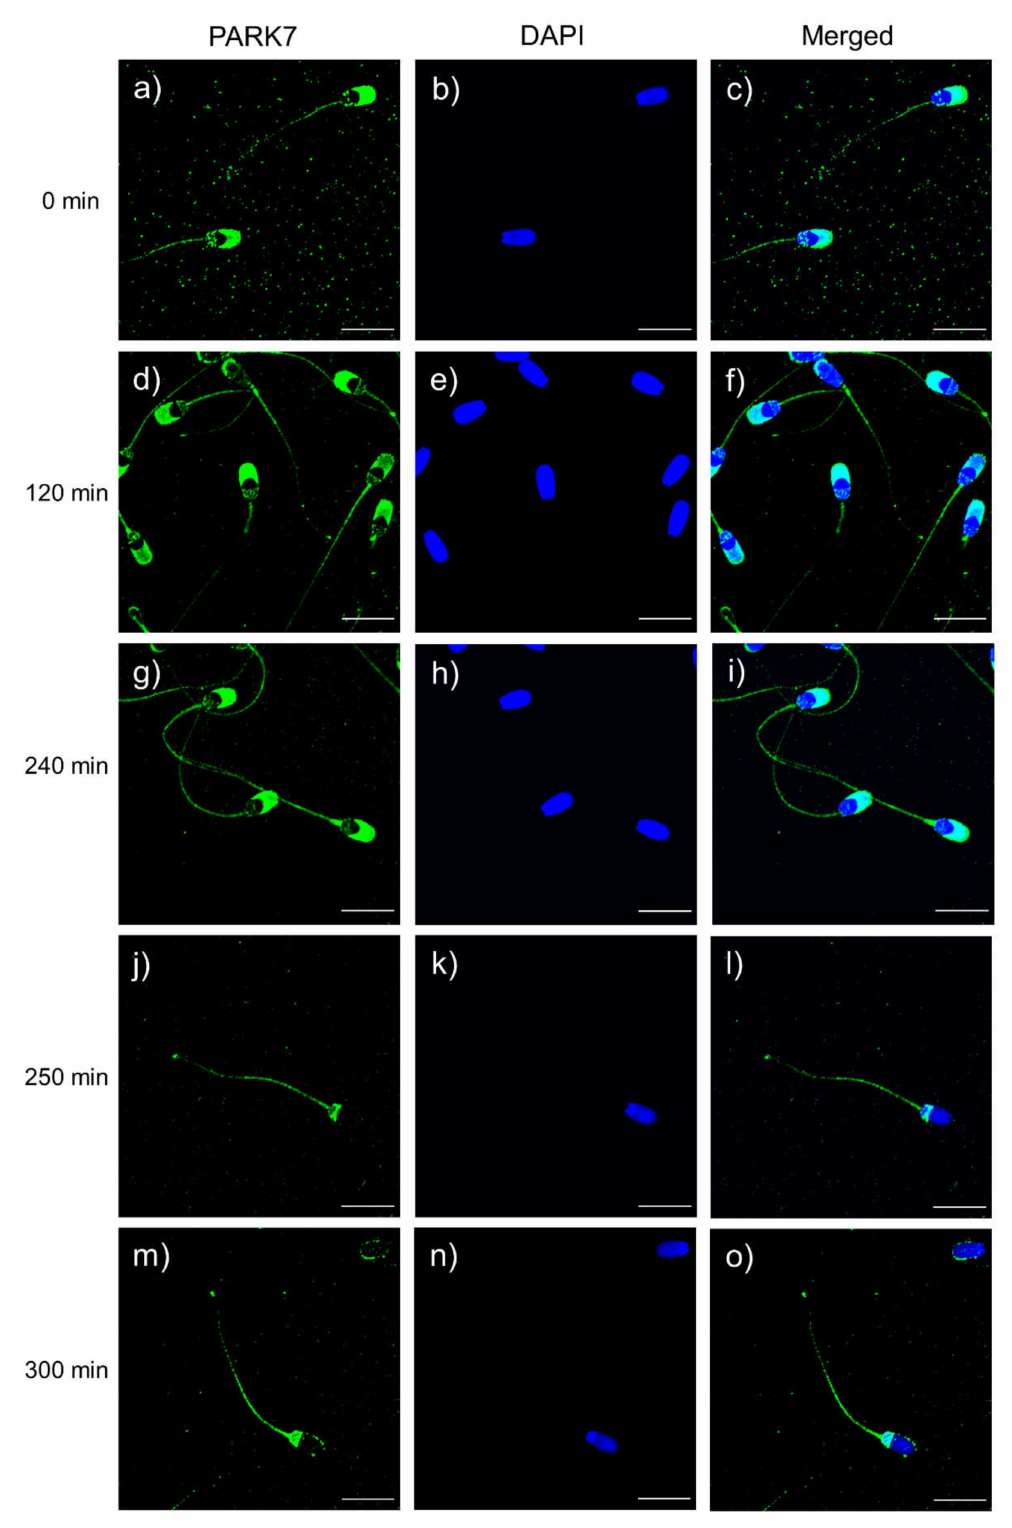
Figure 7. Immunolocalization of PARK7 protein at each relevant time point during in vitro sperm capacitation and acrosomal exocytosis: 0 min ( a – c ); 120 min ( d – f ); 240 min ( g – i ); 250 min ( j – l ); and 300 min ( m – o ). PARK7 fluorescence is shown in green, and nuclei are shown in blue (DAPI). Scale bar: 13.2 µ